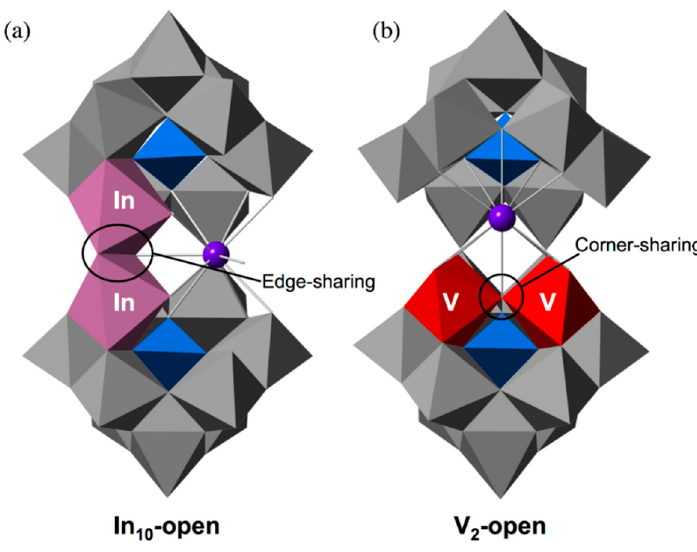
Figure 2. The metal arrangement of ( a ) In 10 -open and ( b ) V 2 -open in the open pocket.